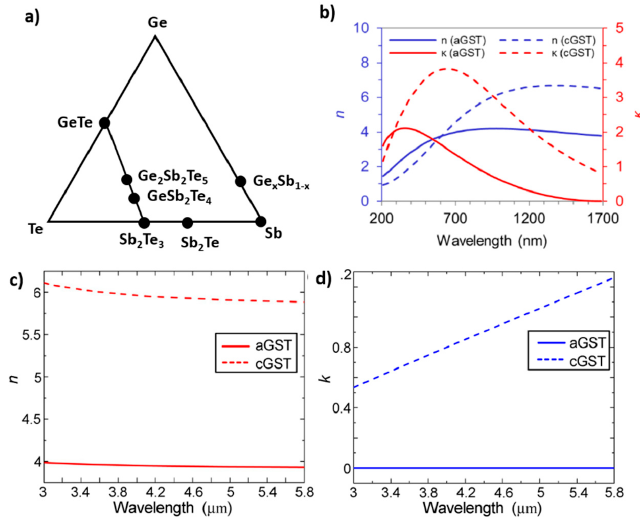
Figure 1. ( a ) Ternary phase diagram for Ge, Sb and Te showing most common chalcogenide phase change materials; ( b ) variation in the visible range of the real ( n ) and imaginary ( k ) part of the refractive index of Ge 2 Sb 2 Te 5 (GST225) upon phase transition [14]; ( c ) variation in the IR range of the real ( n ) part of the refractive index of GST225 upon phase transition [15]; ( d ) variation in the IR range of the imaginary ( k ) part of the refractive index of GST225 upon phase transition [15]. Reproduced from Refs. [14,15] with permission from Optical Society and